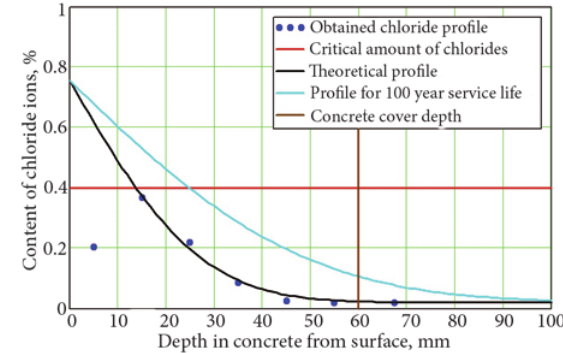
fig. 19. Calculation of chloride profiles (profile P5-3) at deterministic level